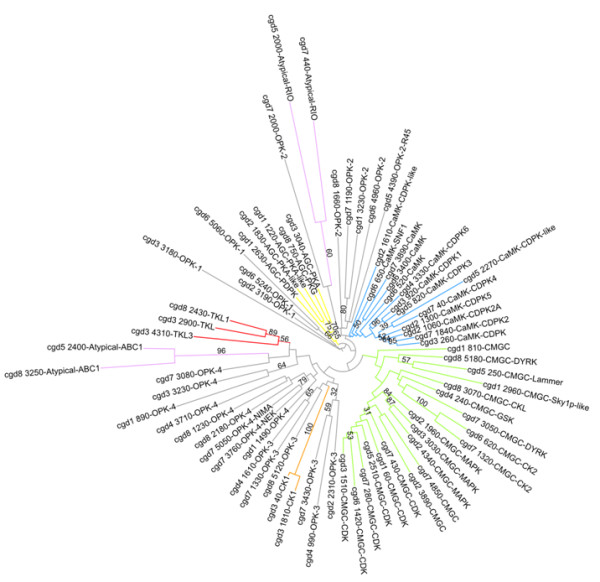
Maximum likelihood tree from a rapid bootstrap analysis describing the classification of the 73 C. parvum protein kinases. The families are colour-coded as follows: AGC (yellow), CK1 (orange), Atypical (pink), CaMK (blue), CMGC (green), TKL (red), and OPK (grey).